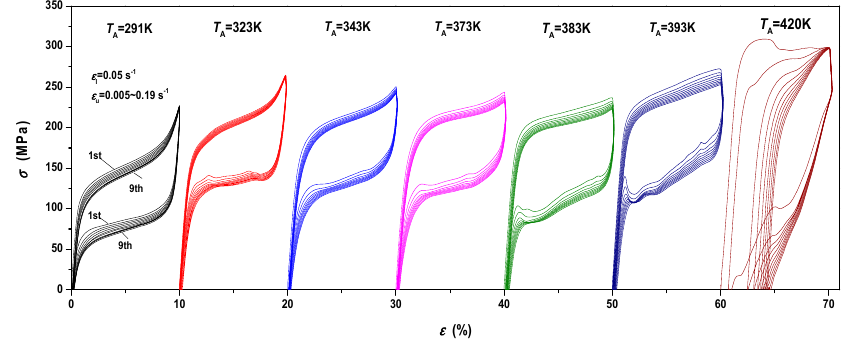
Figure 3. Stress-strain curves for the columnar-grained Cu 71 Al 17.5 Mn 11.5 shape memory alloys (SMAs) with different unloading strain rates ( ε(cid:4662) u = 0.005–0.19 s − 1 ) at different measuring temperatures.